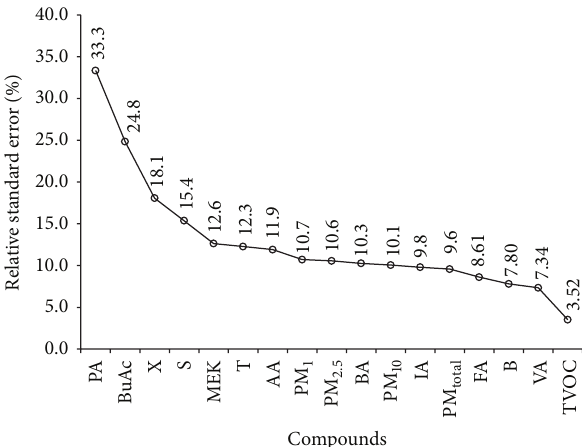
Figure 2: The relative standard error (RSE, %) values of the concentrations of target compounds obtained from a total of 11 repeat pan fryings of mackerel